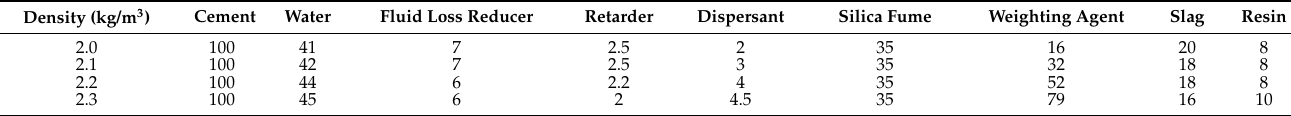
Table 2. Composition of high-density cement slurries. Unit: